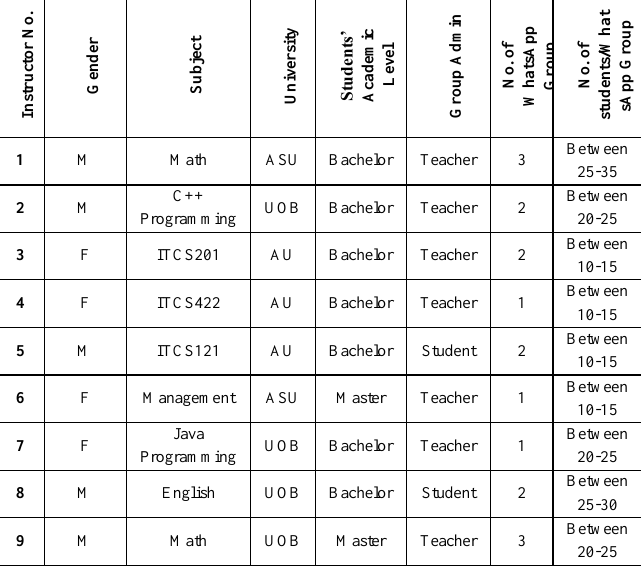
Table 1: Charastrastics of teacher